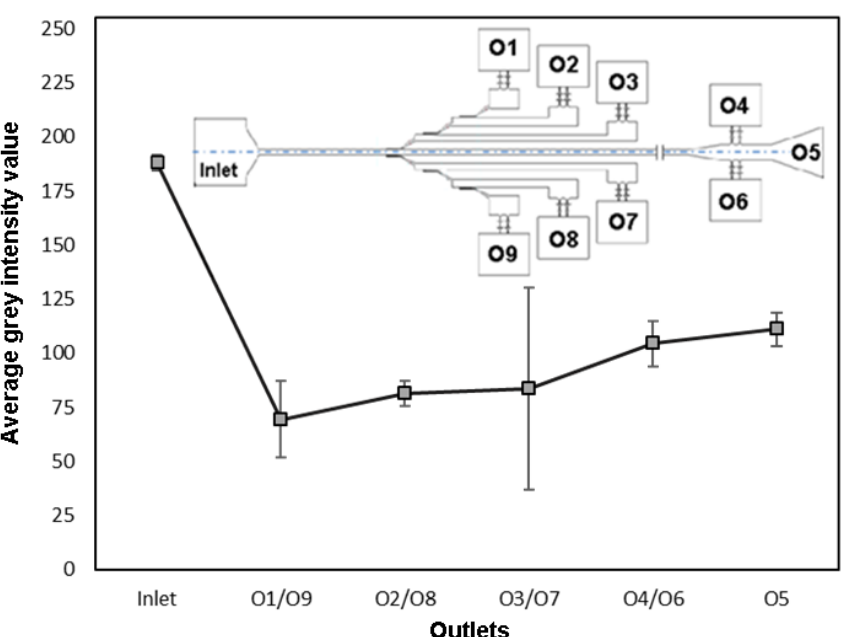
Figure 9. Average gray intensity value (a.u., ranging from 0 to 255) at the inlet and 9 outlets of the microfluidic device.